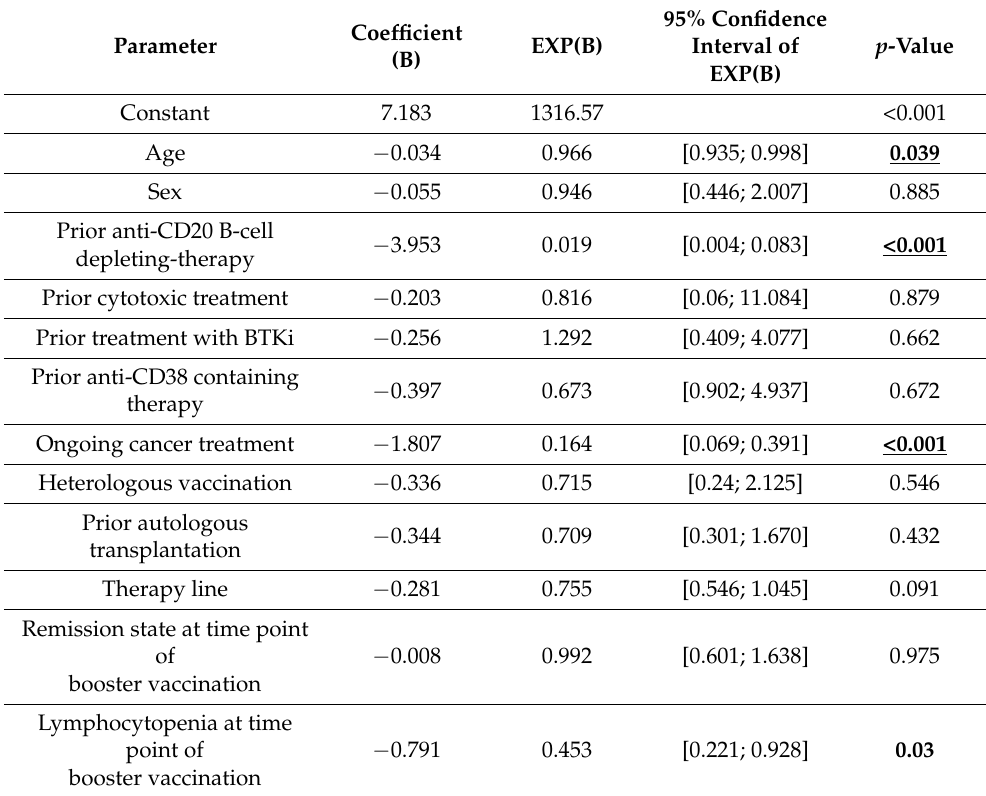
Table 3. Bivariable analysis of factors associated with lack of seroconversion following prime-boost vaccination in patients with hematologic